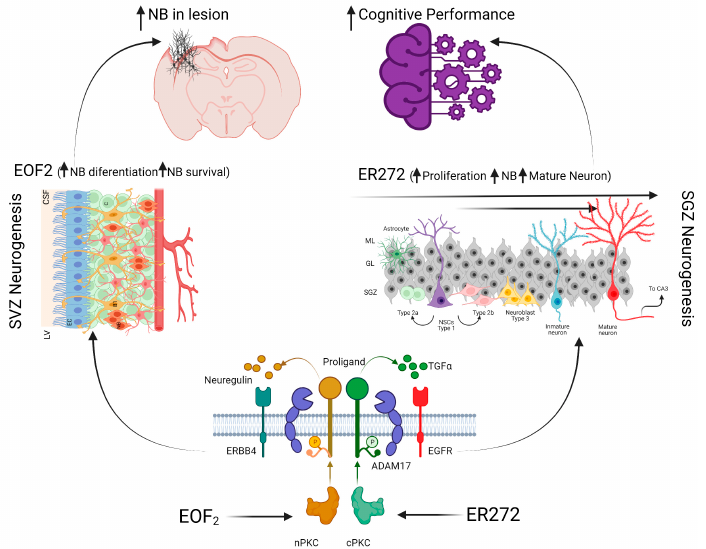
Figure 2. Effects of diterpenes on adult neurogenesis and its functional implications. In the bottom, it is represented how the different diterpenes act on their kinase targets, initiating the PKC-ADAM17 signaling pathways. In the top is represented its effects on SVZ and hippocampal neurogenesis and its potential benefits. EOF2 activates nPKC, which mainly induces neuregulin release and promotes neuroblast differentiation and migration to the injured areas. ER272 activates cPKC, which induces TFG α release and active hippocampal neurogenesis, improving cognitive performance. ADAM17, tumor necrosis factor- α -converting enzyme; CSF, cerebrospinal fluid; EC, ependymal cells; EGFR, epidermal growth factor receptor 1; GL, granular layer; ML, molecular layer; LV, lateral ventricle; NB, neuroblast; NSCs, neural stem cells; cPKC, classical protein kinase C; nPKC, novel protein kinase C; SVZ, subventricular zone; SGZ, subgranular zone; TFG α , transforming growth factor alpha. Created with BioRender.